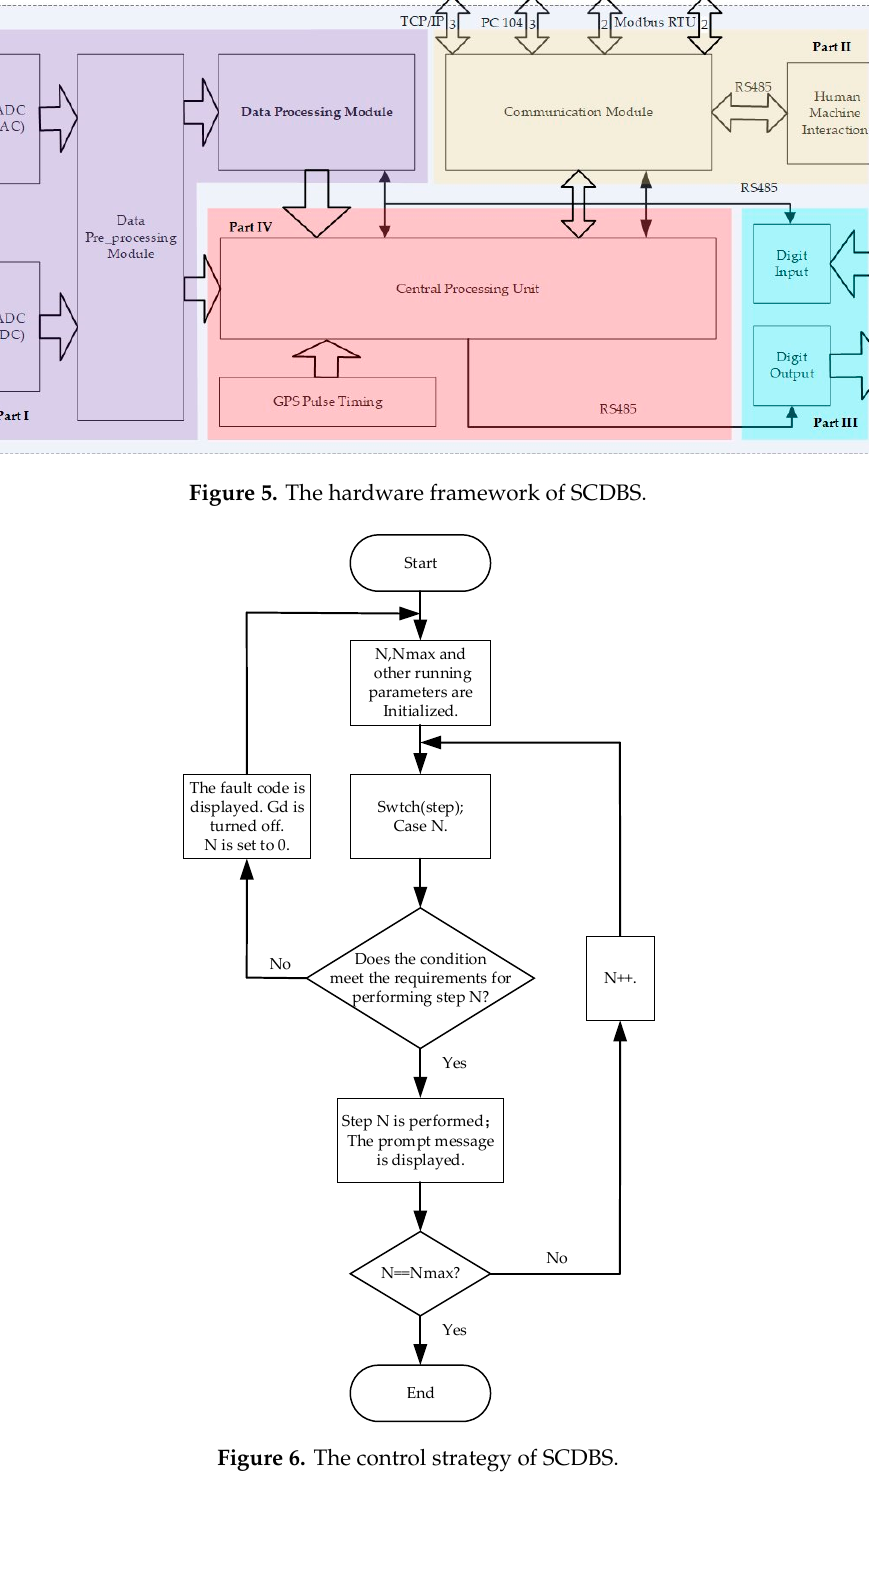
Figure 4. The logic relationship of SCDBS.